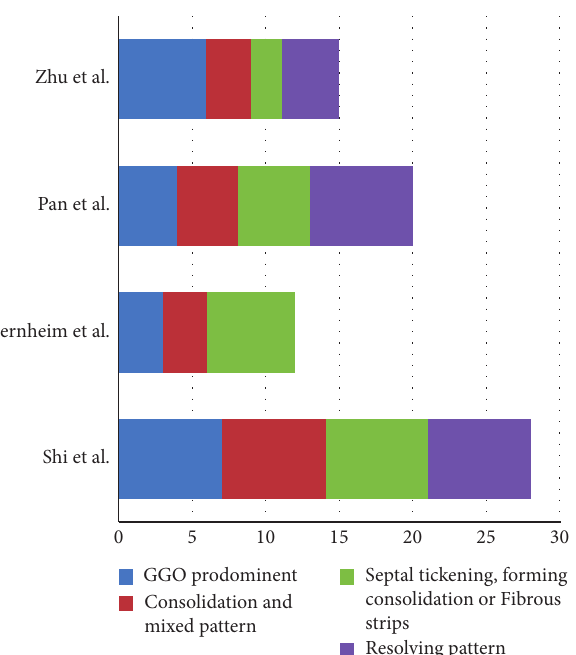
Figure 4: Comparison of CT findings in four studies with time course